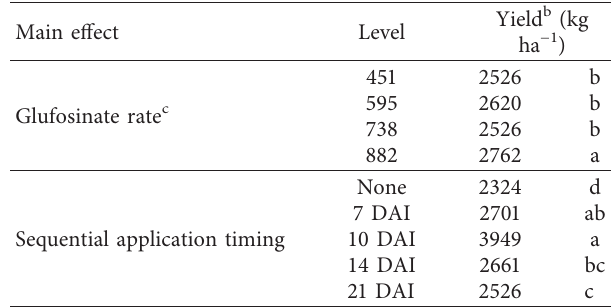
DAI, days after initial application. b For a given main effect, means within a column followed by the same letter are not different according to (Table 6), but both main effects and data are presented in Table 8. Averaged across sequential application timings,